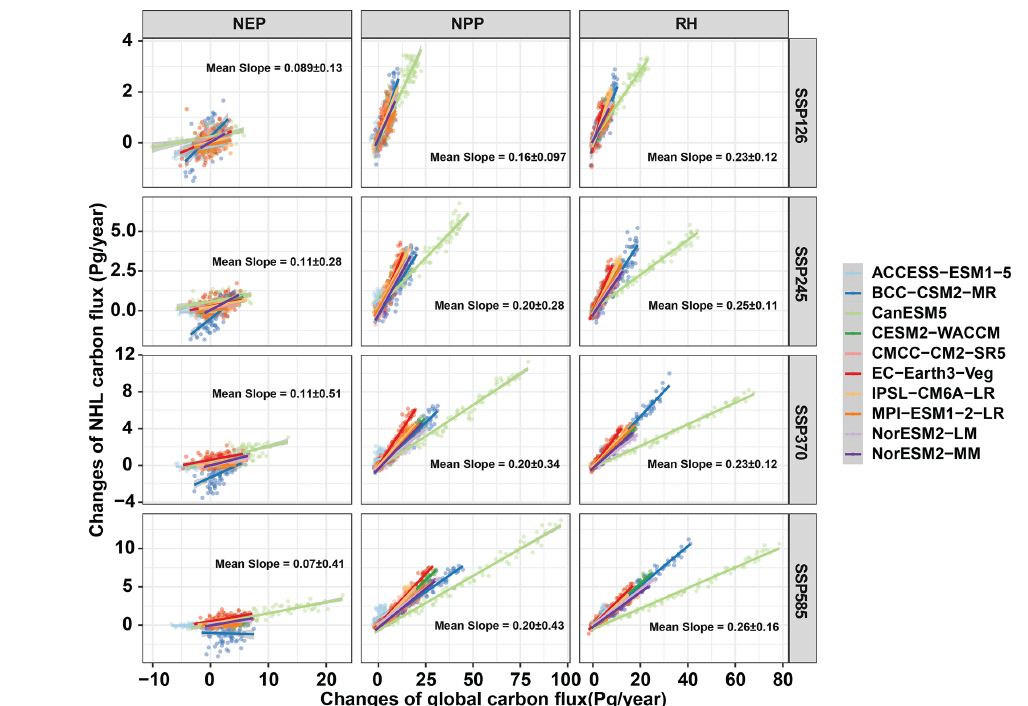
Figure 6. Changes in NHL carbon fluxes relative to the changes in global carbon fluxes, as indicated by the 10 CMIP6